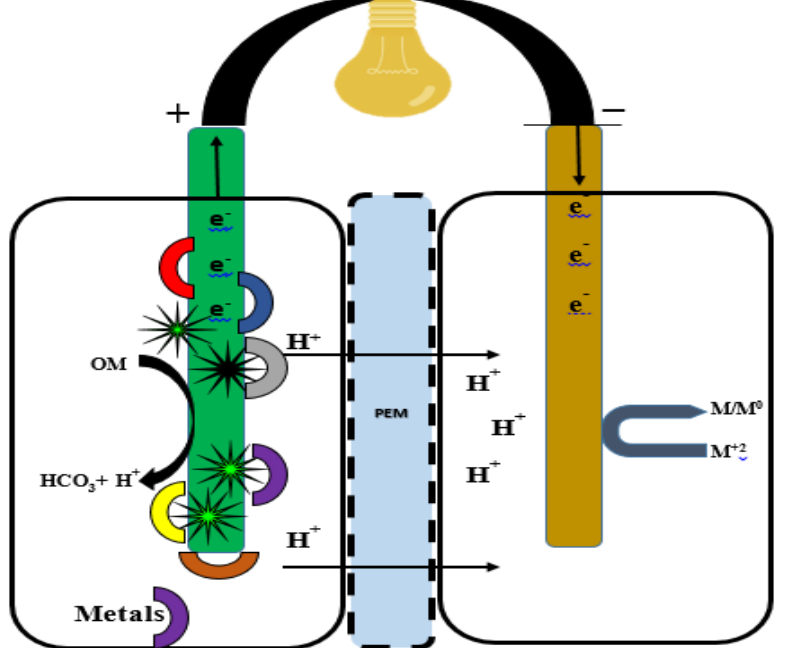
Figure 6. A double-chambered fungal fuel cell for the treatment of heavy metals. Heavy metal-contaminated water is placed in the anodic cell (aerobic compartment), where fungi enzymatically release carbon, e − and H + transfer via PEM and external wire to the cathodic cell (anaerobic compartment), where the reduction of the metal from M +2 to M/M 0 takes places.